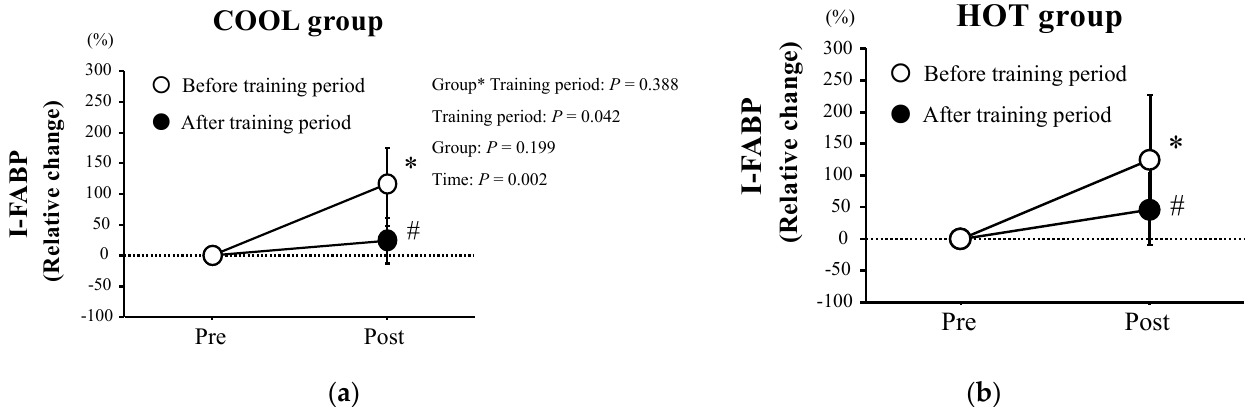
Figure 2. Relative changes in plasma I − FABP concentrations in both COOL ( a ) and HOT groups ( b ). Values are means ± SD. *: Significant difference compared with pre-exercise (Pre). #: Significant difference versus before at the same time point.